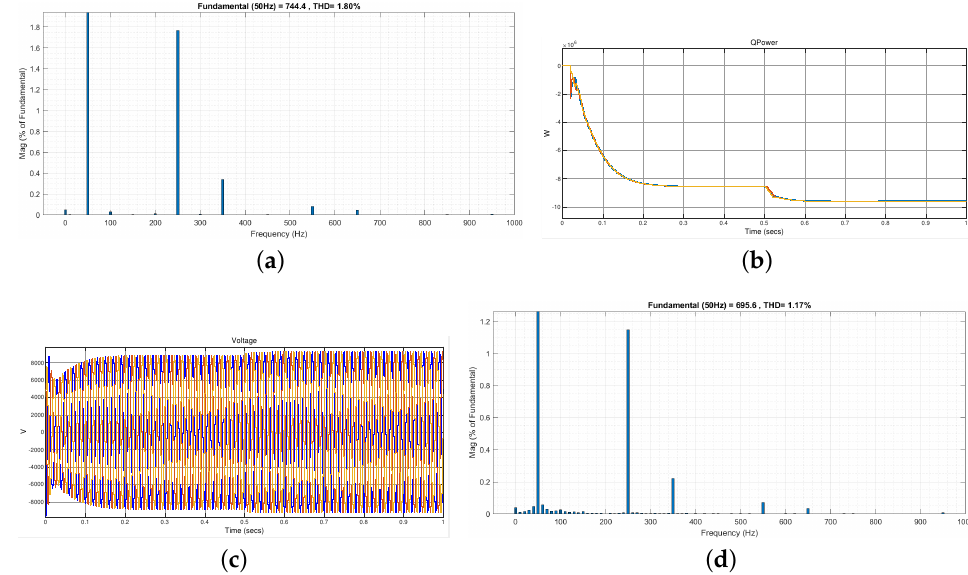
Figure 5. Harmonics, Reactive power and voltage in utility grid. ( a ) Harmonics when all chargers are operated. ( b ) Reactive power in utility grid when CSs operated with DCFCs. ( c ) Voltage in utility grid when CSs operated with DCFCs. ( d ) Harmonics in utility grid when CSs operated with